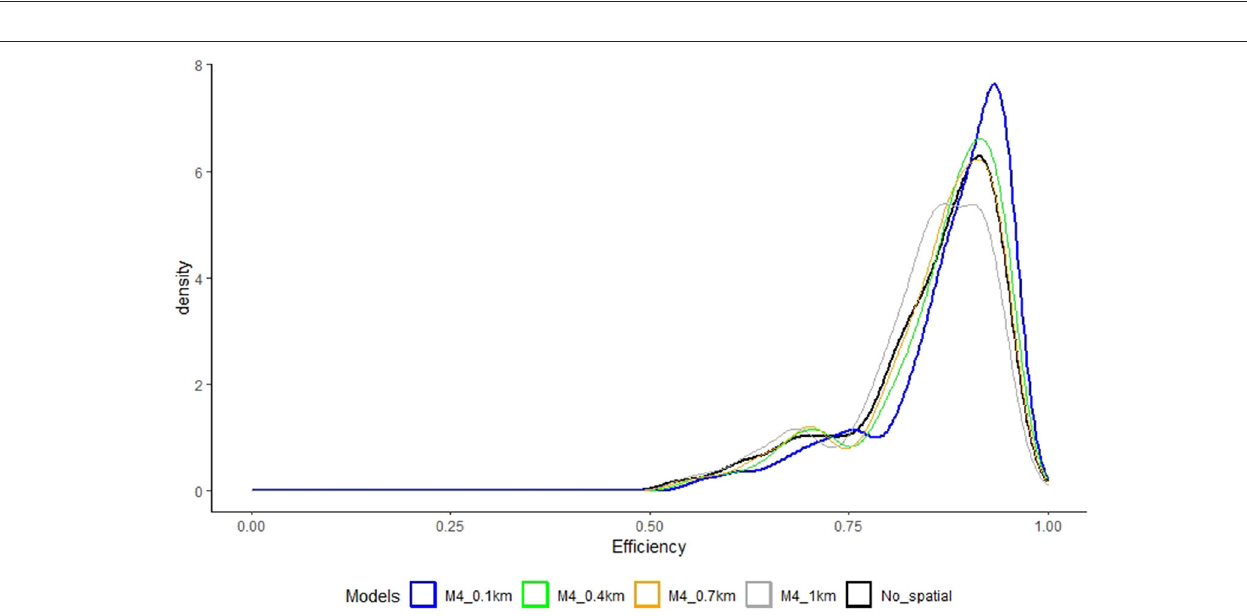
FIGURE 9 | Model 4 vs. non spatial: Farm technical efficiency distribution for rainfed farms at different cut-off distances.